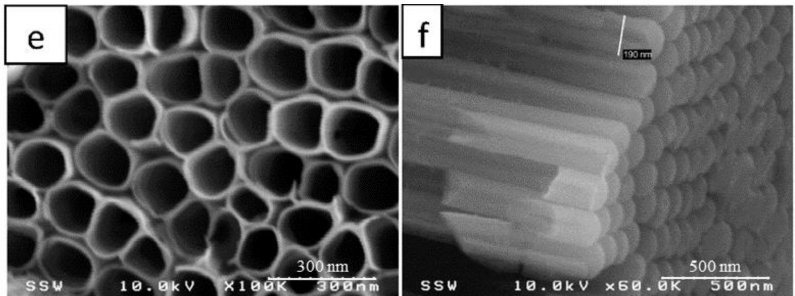
Figure 1. FESEM images for TNTAs synthesized in ethylene glycol electrolyte containing 1 wt % H 2 O and 0.4 wt % NH4F at constant potential of 60 V; ( a , b ) Tope view and cross sectional view of TNTAs anodized for 6 h and then sonicated in water for 5 min to clean surface and remove debris; ( c , d ) are top and cross sectional views of TNTAs anodized at the same conditions for 10 h; and ( e , f ) are high magnification of top and lateral views of TNTAs in ( a ), respectively.